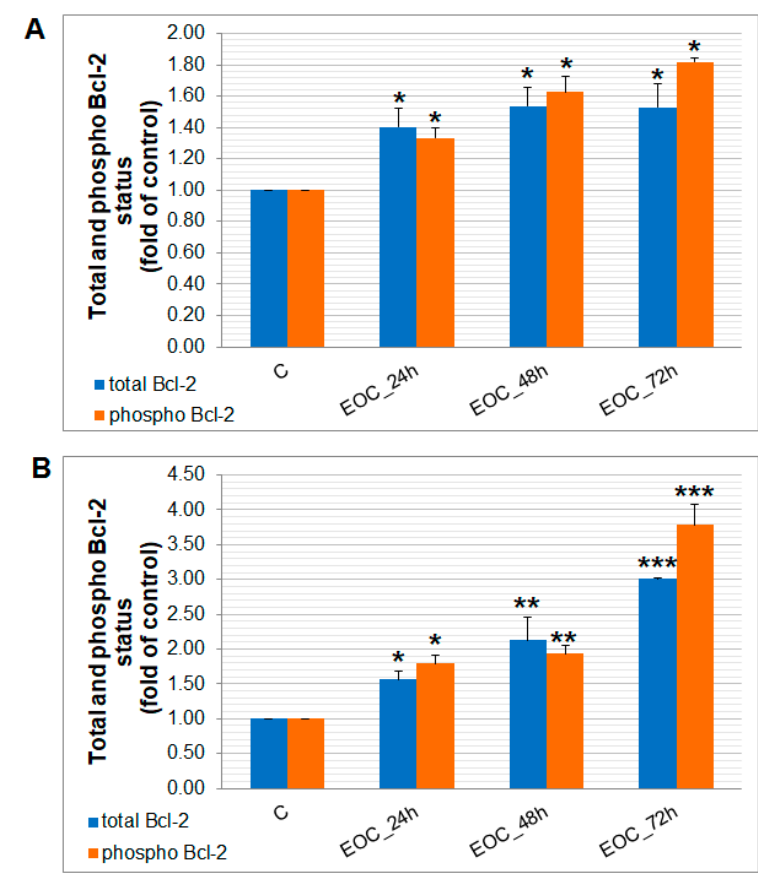
Figure 14. Distribution and activity of antiapoptotic mitochondria-associated protein Bcl-2 after EOC treatment (1:25,000, 1:65,000) in MCF-7 ( A ) and MDA-MB-231( B ) cells analyzed by flow cytometry. Results are expressed as mean values of three independent experiments and significant di ff erences were marked as p < 0.05 (*), p < 0.01 (**), p < 0.001 (***) vs. untreated